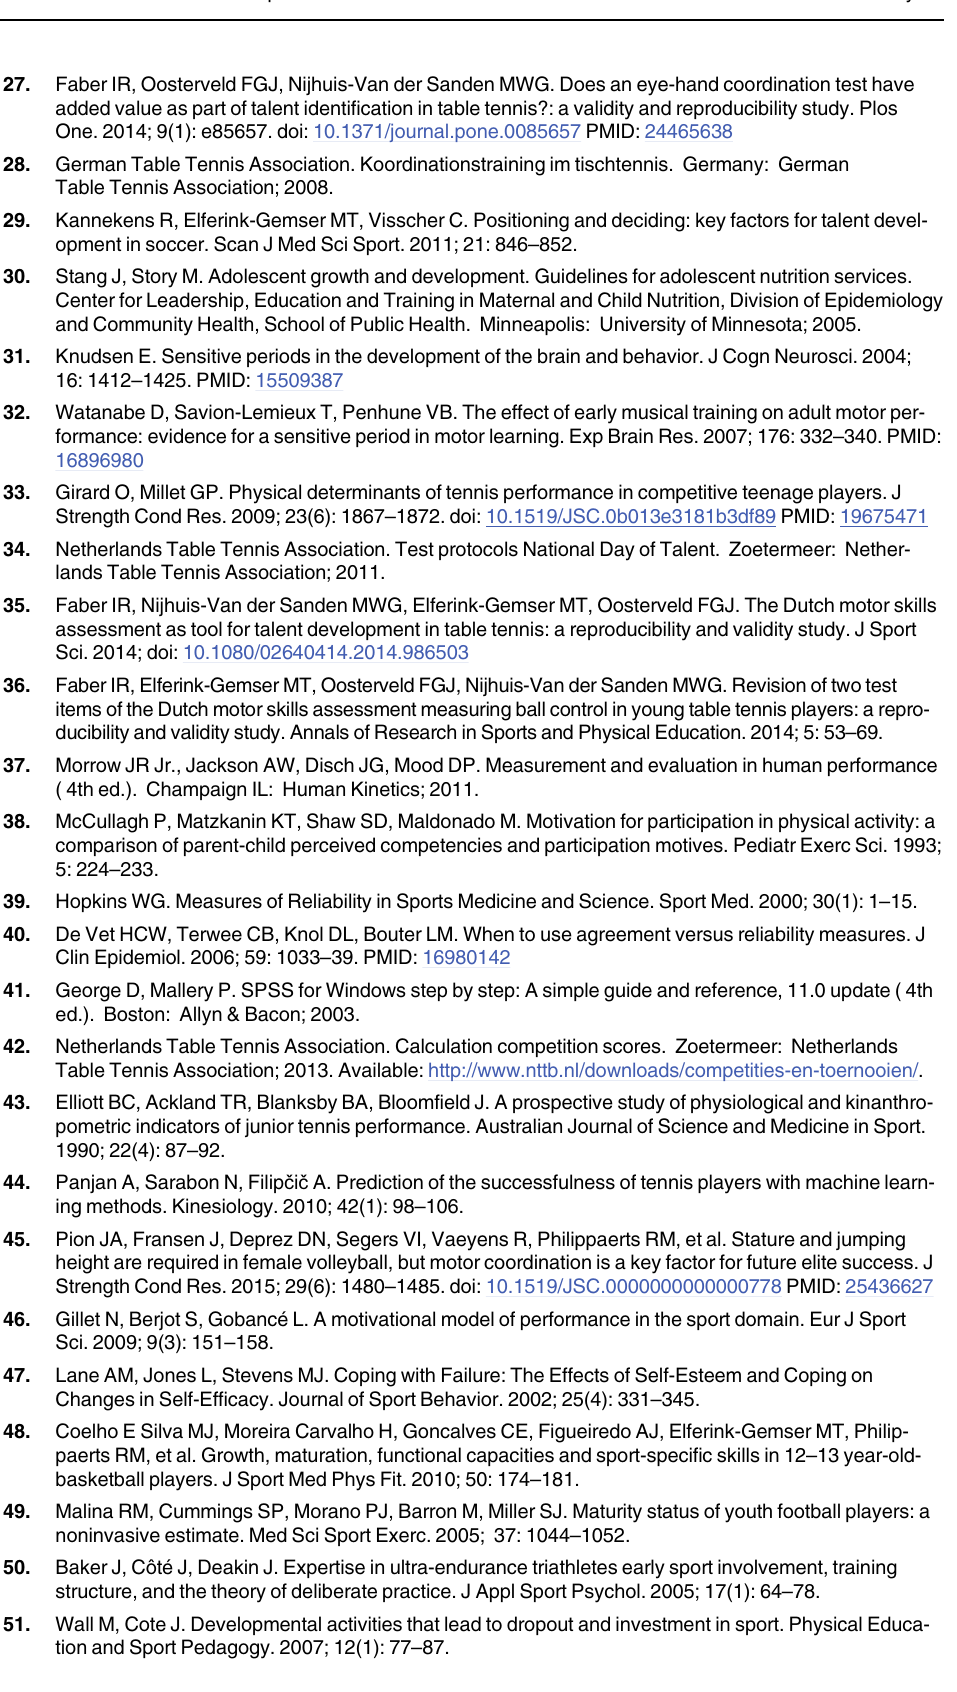
34. Netherlands Table Tennis Association. Test protocols National Day of Talent. Zoetermeer: Nether- lands Table Tennis Association; 2011.